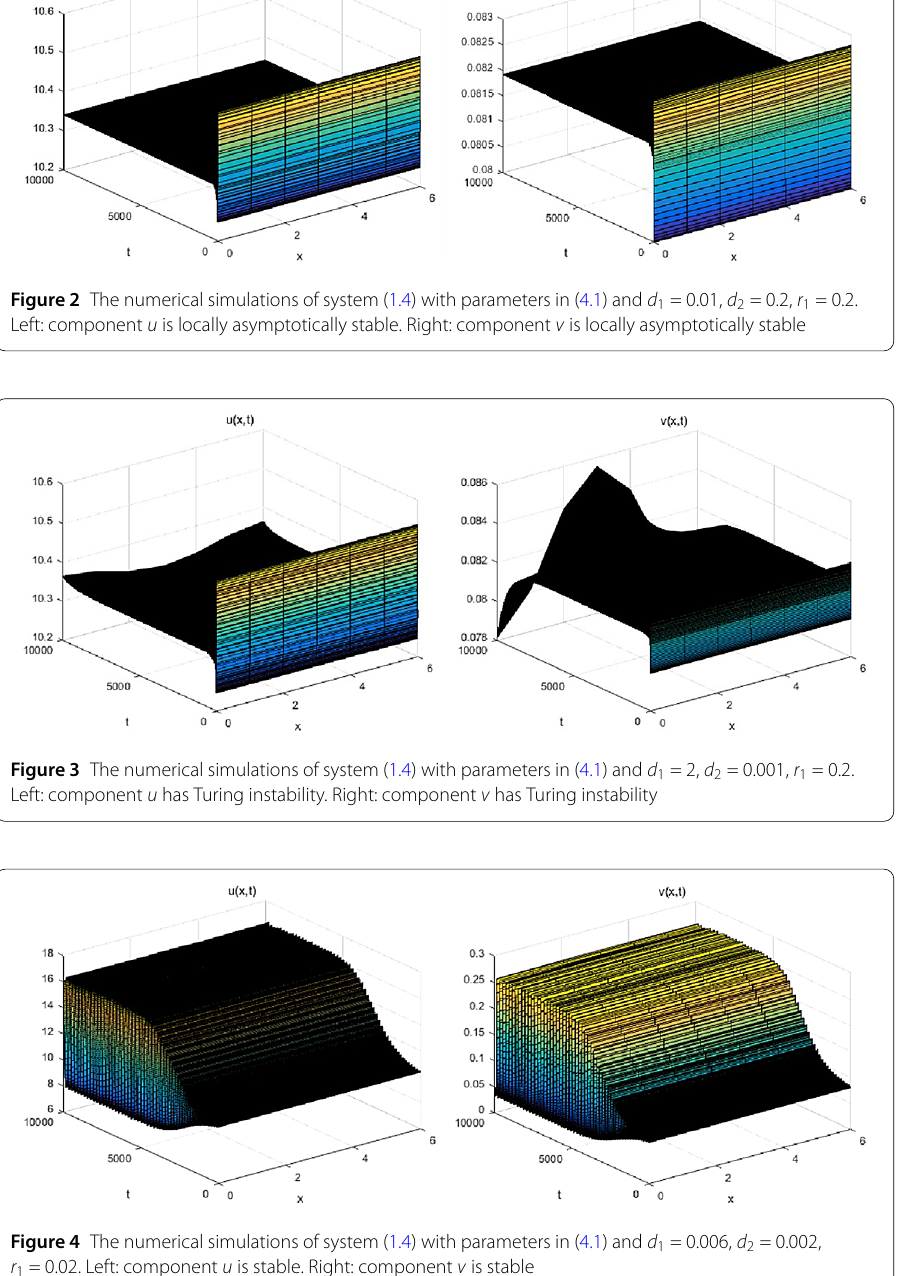
For the positive equilibrium p ( u 0 , v 0 ) = ( u 0 , v 0 ) 1 , choose d 1 = 0.006, d 2 = 0.002. By com- (0) ≈ 0.114 and Re ( c putation we have r (0) )) ≈ –2.830 × 10 –3 < 0. So we conclude that the 1 ( r 1 1 positive equilibriums p ( u 0 , v 0 ) loses its stability, and system (1.4) undergoes a Hopf bifur- cation when r 1 crosses r (0) . Moreover, the direction of the bifurcation is toward the back, 1 and the bifurcating periodic solutions are asymptotically stable by Theorem 3.1, which is shown in Fig.